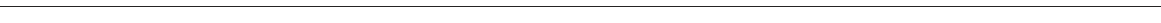
FIGURE5(Continued) lncRNA-miRNA- HSD17B7 networks. (E) : Interaction between lncRNA NONBTAT027373.1 and miR-664b through Ago2 protein investigated using the RIP assay. lncRNA NONBTAT027373.1 and miR-664b expression quantified by RT-qPCR. (F) : Schematic view of the miR-664b seed region, the motif of HSD17B7 3’-UTR and lncRNA NONBTAT027373.1. (G,H) : Construction of WT and MUT plasmid vectors of HSD17B7 3’-UTR and lncRNA NONBTAT027373.1. (I) : Dual-luciferase reporter gene analysis of the regulatory relationship between HSD17B7 3’-UTR